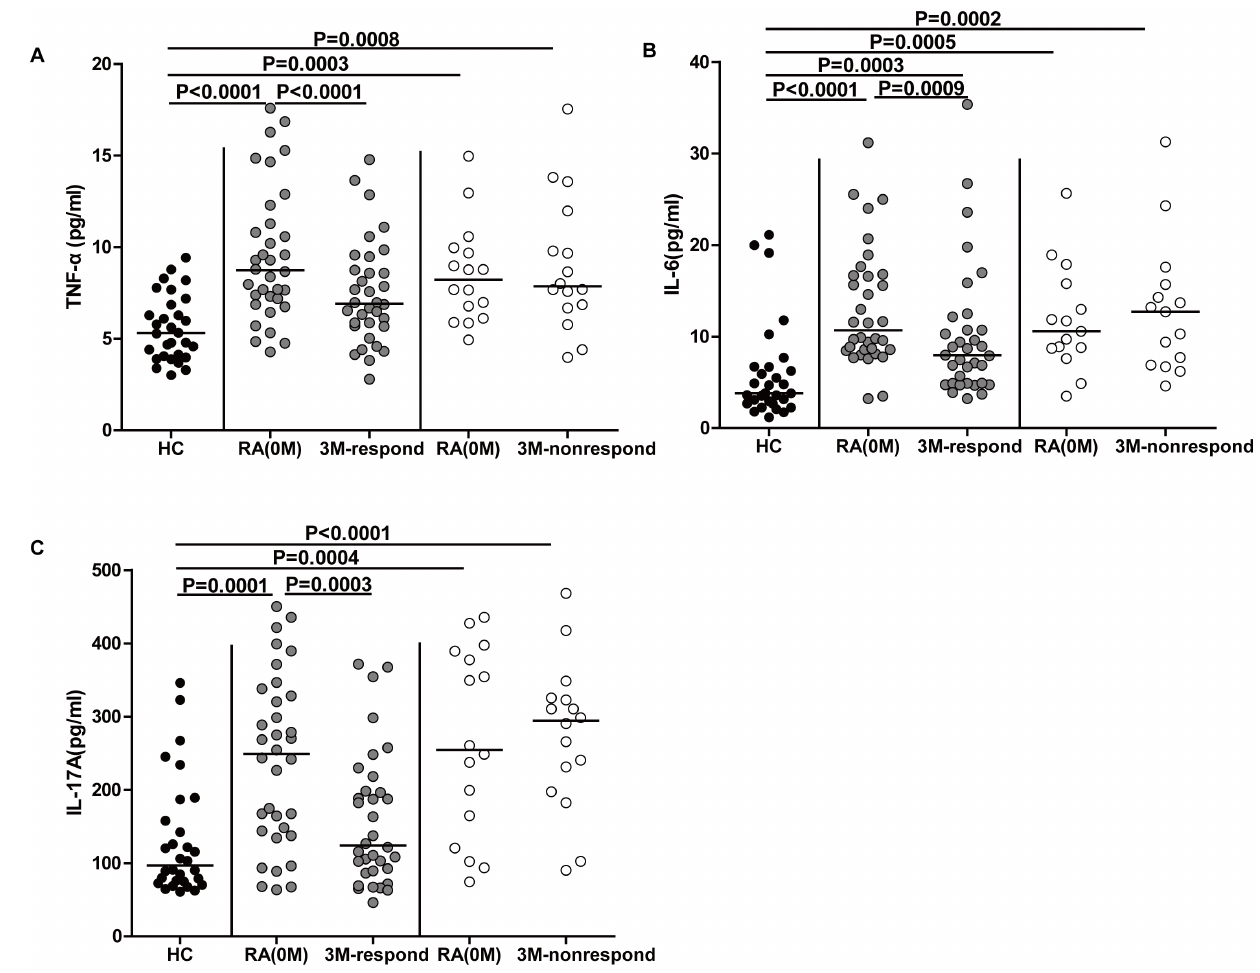
Figure 2. Plasma levels of TNF- a , IL-6 and IL-17A in RA patients. ( A ) Plasma levels of TNF- a in HCs, drug responders, and drug non- responders at baseline and after three months of treatment. ( B ) Plasma levels of IL-6 in HCs, drug responders (grey dots), and drug non-responders at baseline and after three months of treatment (white dots). ( C ) Plasma levels of IL-17A in HCs, drug responders (grey dots), and drug non-responders at baseline and after three months of treatment (white dots). The horizontal lines indicate the median values of the different groups. The difference between the groups was analyzed by Mann-Whitney test and Wilcoxon signed rank tests for unpaired and paired comparisons, respectively.